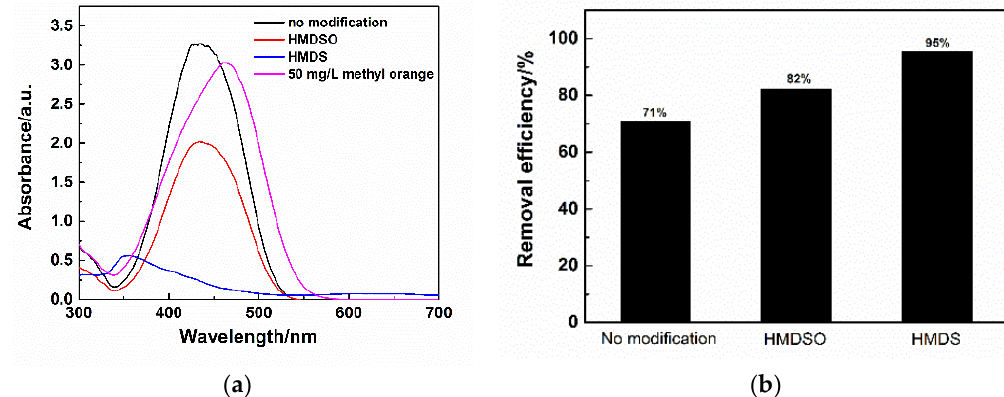
Figure 12. ( a ) UV visible absorption spectra of filtrates filtered by flexible MSQ aerogels ( X 1 = 6 mL) with different surface modifications and 50 mg·L − 1 methyl orange standard solution; ( b ) Removal efficiency of flexible MSQ aerogels with different surface modifications.